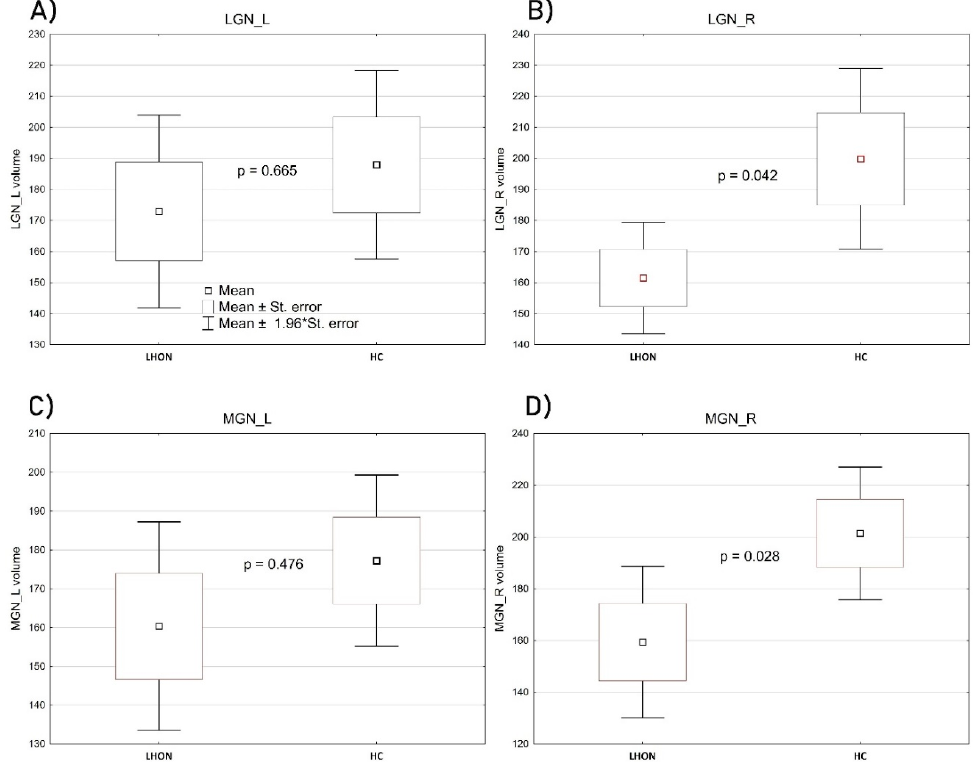
Figure 4. Between-group comparisons of the LGN (( A )—left, ( B )—right) and MGN (( C )—left, ( D )—right) volumes (mm 3 ). The figures show mean, standard error, the range of 1.96 standard error and the level of statistical difference based on ANCOVA computations. The widest range of results distribution, as depicted in the chart, covers mean ±1.96 x standard error.